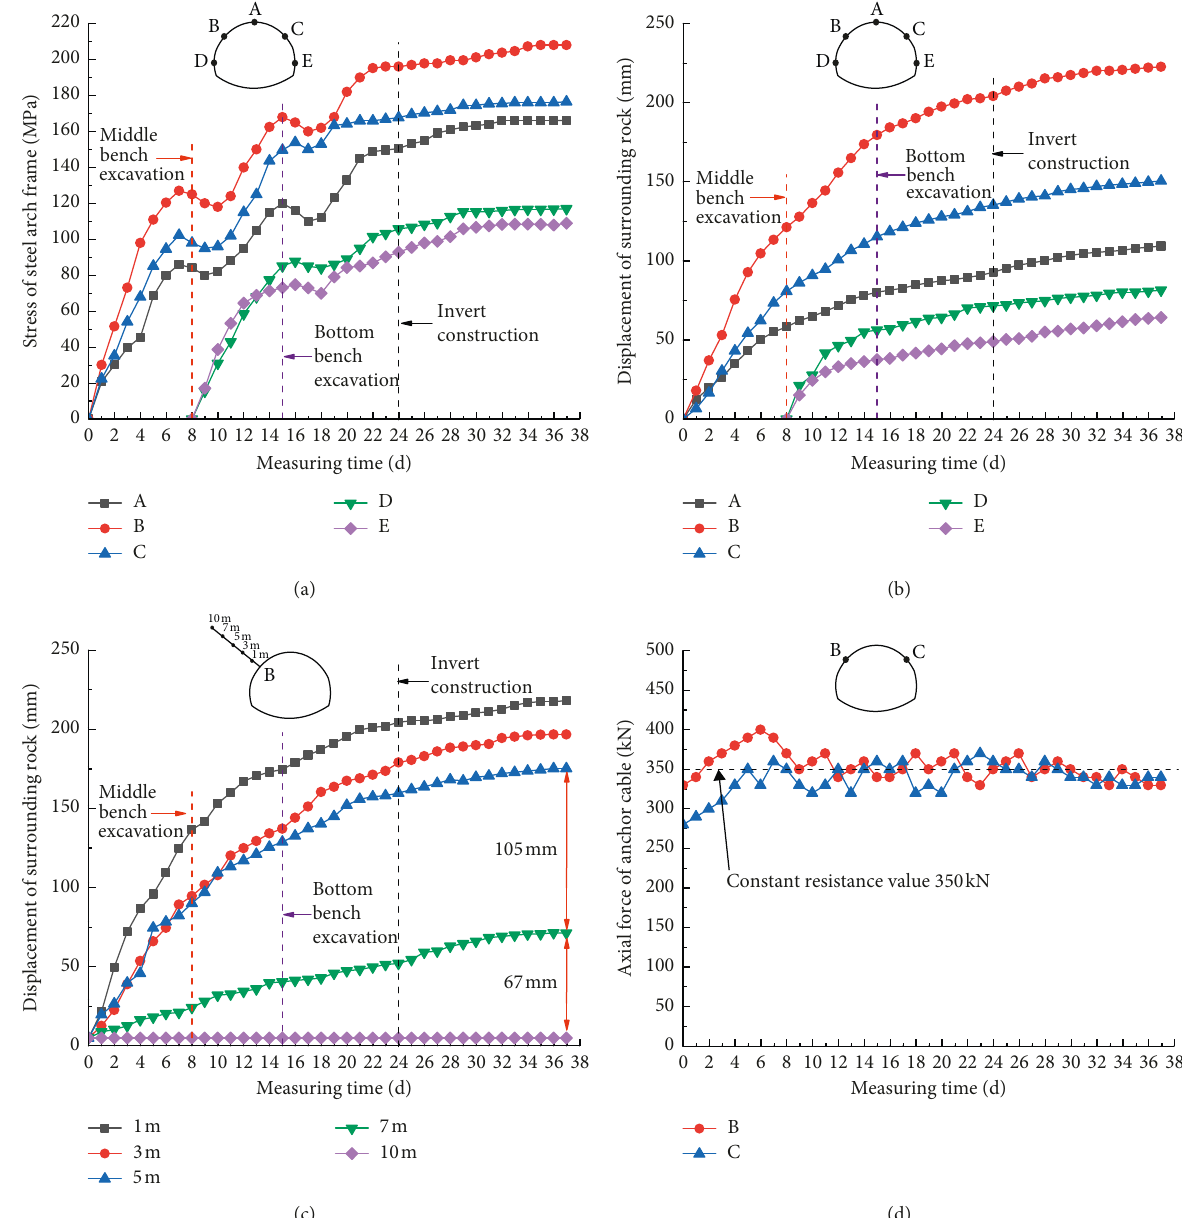
Figure 22: Field test results. Time-history curve of (a) steel arch internal force, (b) surrounding rock displacement, (c) surrounding rock deep displacement, and (d) anchor cable